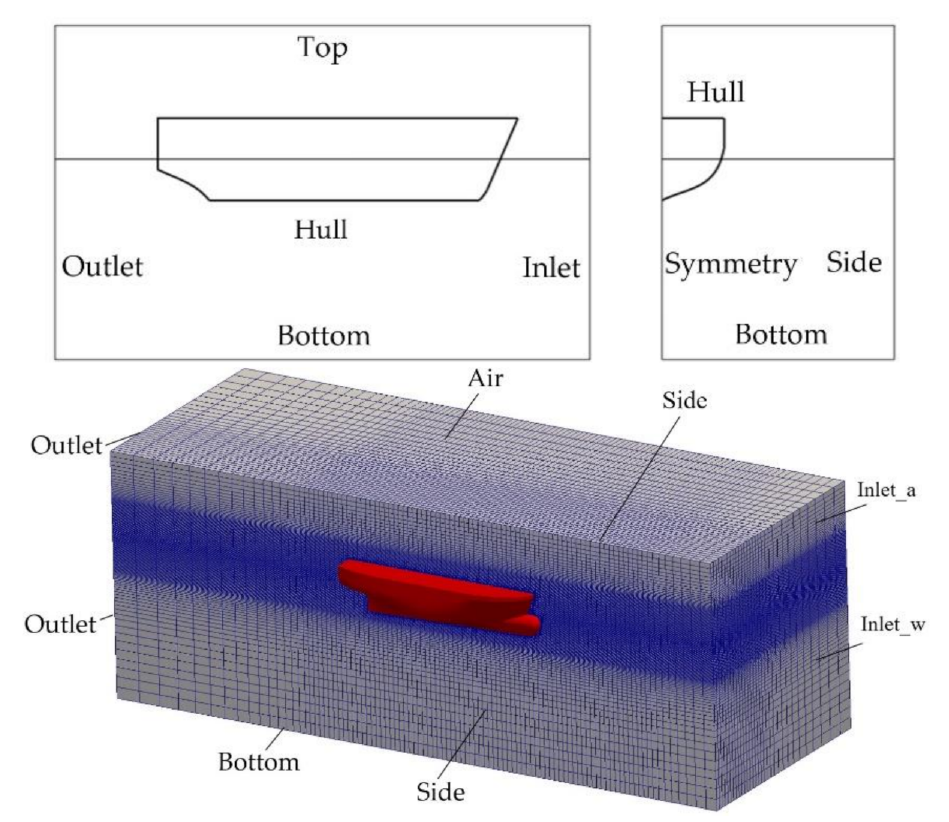
Figure 5. Computation domain with boundary conditions ( above ) and a grid of elements ( below